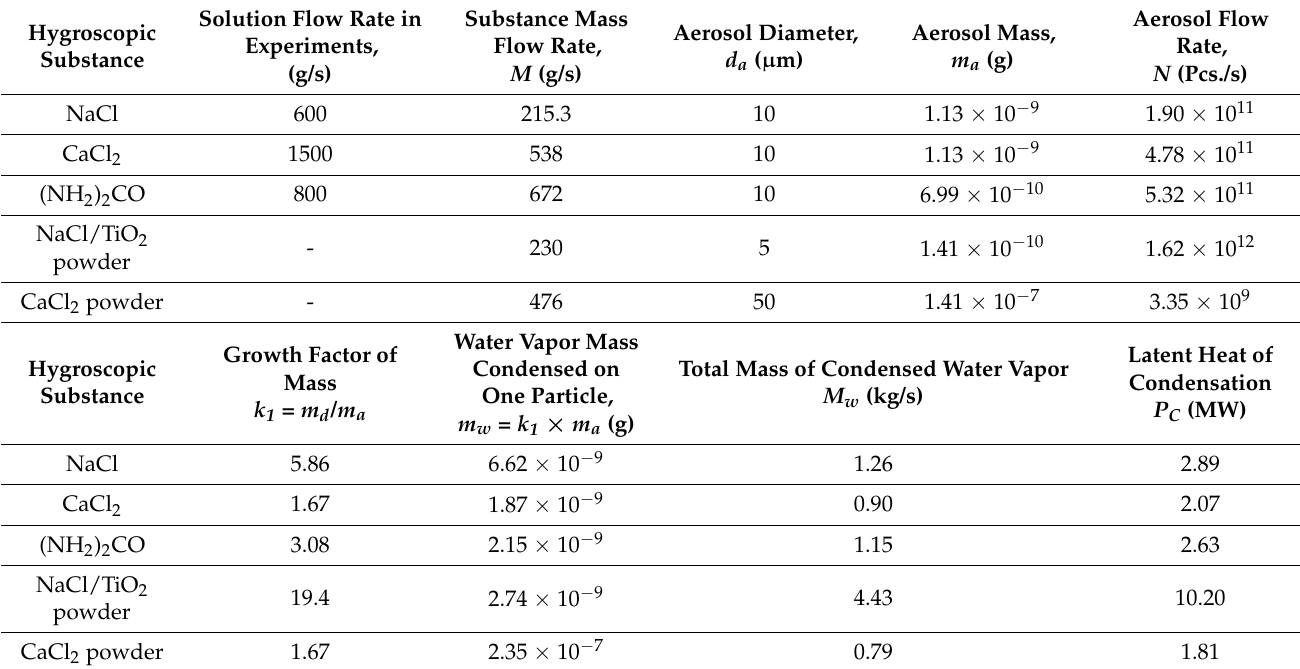
Table 4. Consumption of solutions and powders per experiment, expected amount of condensed water vapor, and condensation heat.